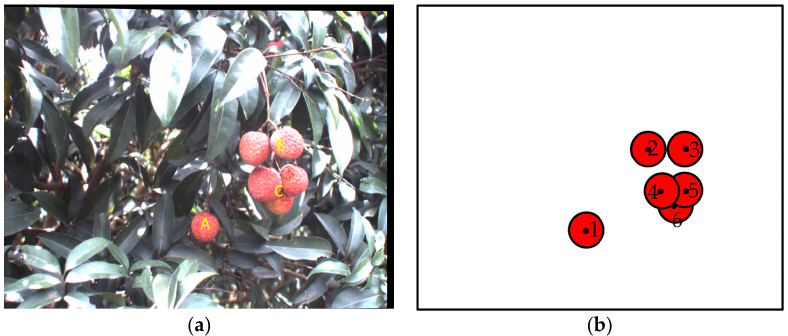
Figure 3. The figure of category definition of clustered litchi fruit: ( a ) A typical litchi canopy image, A is single litchi fruit, B are two clustered litchi fruits, C are multiple clustered litchi fruits; ( b ) An explanation image of clustered litchi fruit category, 1 belongs to single litchi fruit, 2 and 3 belong to two clustered litchi fruits, 4, 5 and 6 belong to multiple clustered litchi fruits.